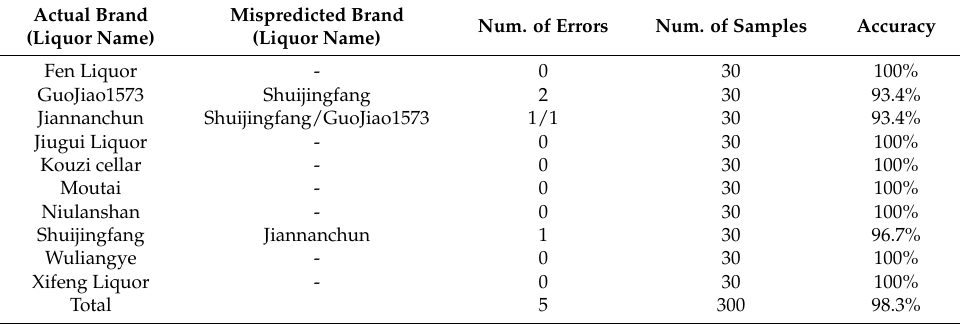
Table 5. Classification results of the Chinese liquor samples by means of the e-nose and the MDS-SVM classifier.